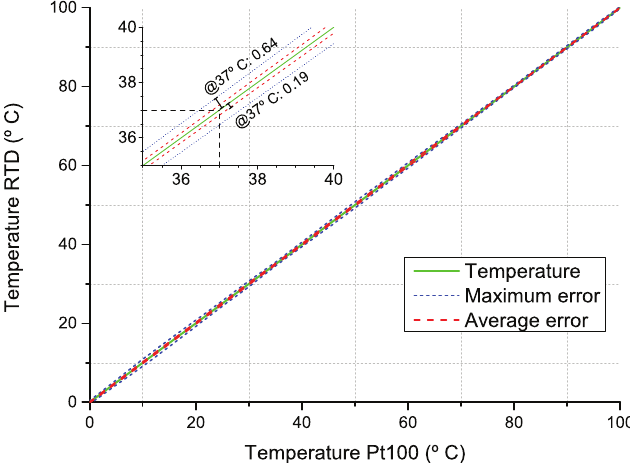
Figure 9. Comparative temperature measurements using Pt100 vs. RTD (green line). Measurement accuracy is given by error lines: maximum error (blue dashed line) and average error (red dashed